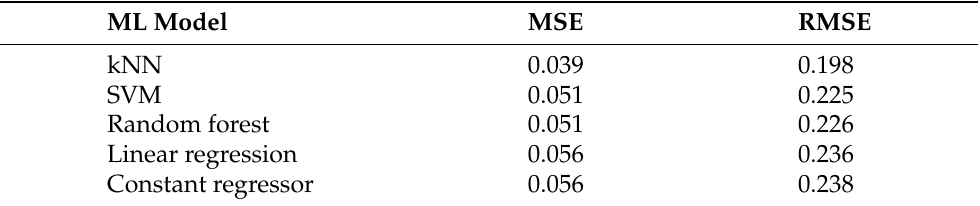
Table 1. MSE and RMSE for the five machine learning models trained to predict the difficulty of each input sample.